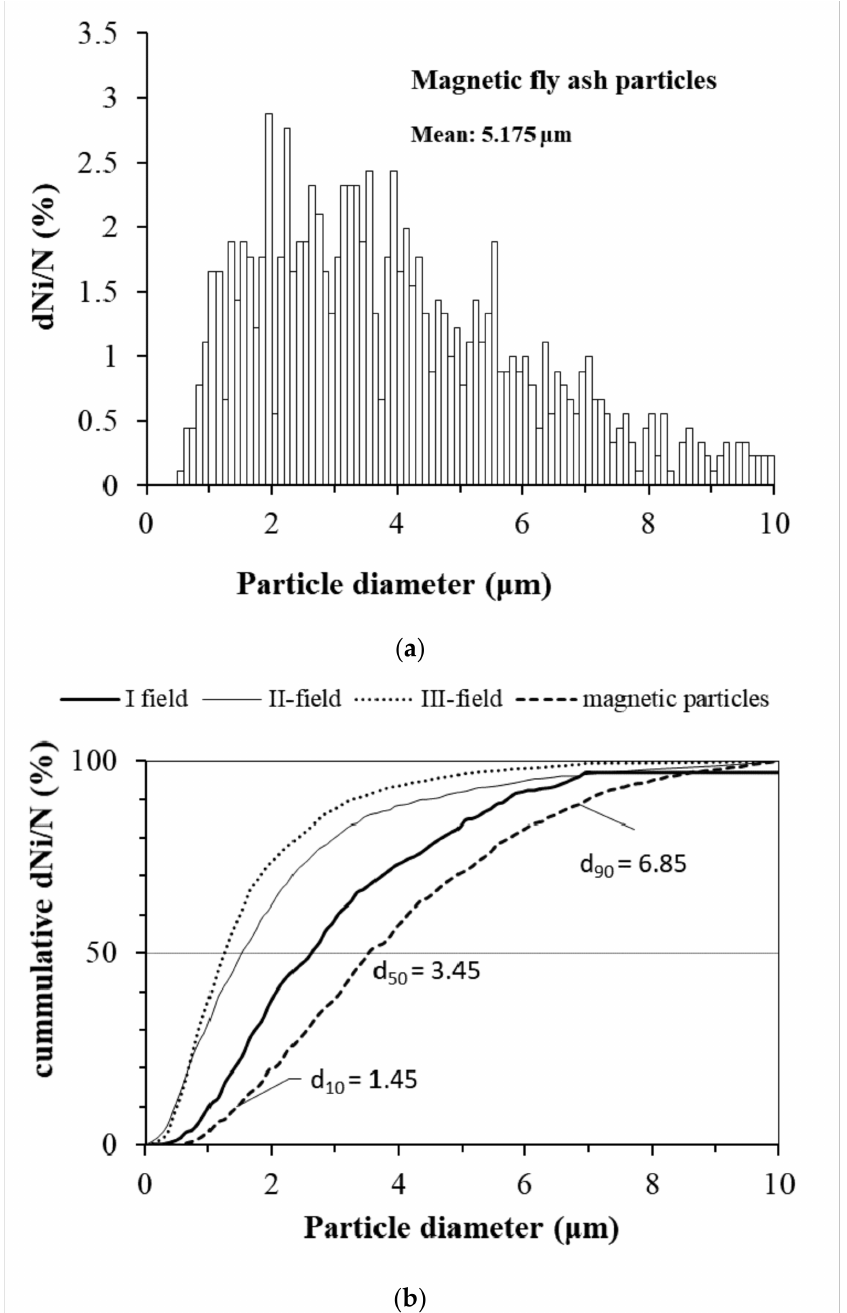
Figure 2. ( a ) Size distribution of the magnetic particles; ( b ) comparison of cumulative number size distributions of magnetic particles and fly ash particles from three fields of the electrostatic